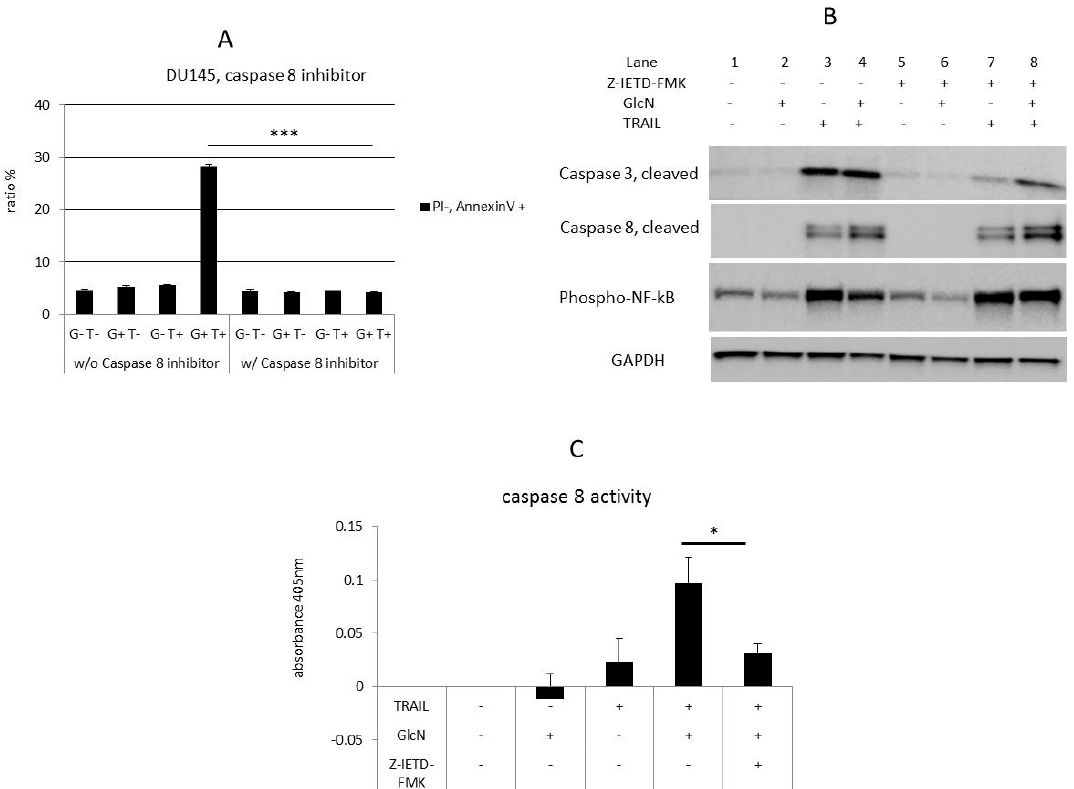
Figure 4. Suppression of caspase 8 activity leads to the rescue of GlcN / TRAIL-induced apoptotic cell death. DU145 cells were treated as in Figure 1C in the absence (-) or presence ( + ) of the caspase 8 inhibitor Z-IETD-FMK. ( A ) After treatment, cells were stained with annexin V / PI and then analyzed by flow cytometry analysis. Bars represent the mean value of three independent assays, *** p < 0.001. ( B ) Whole-cell extracts were prepared and analyzed by immunoblotting with antibodies against cleaved caspases 3 and 8, and phospho-NF-kB. ( C ) Caspase 8 activity was measured. Bars represent